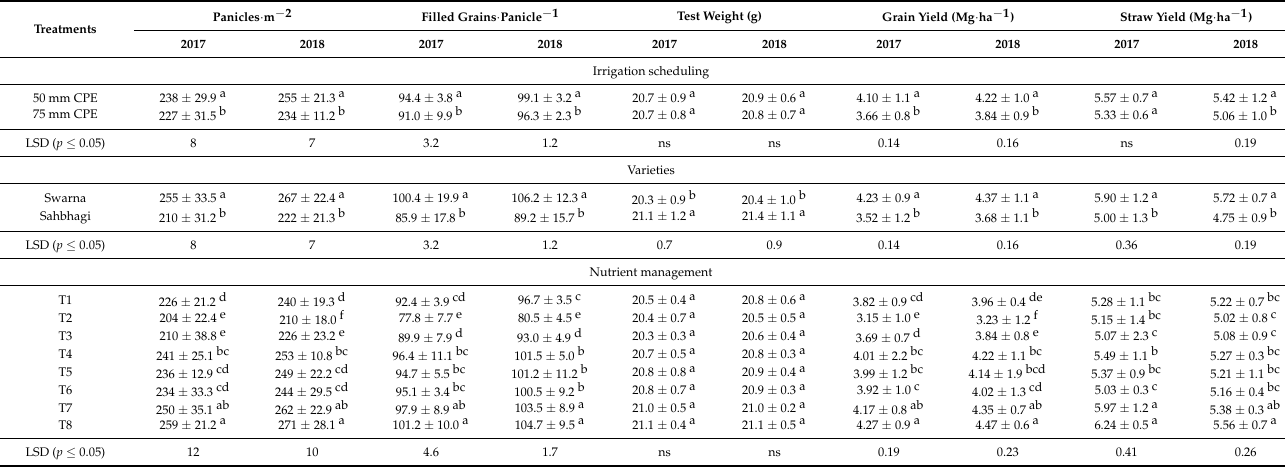
Table 5. Yield attributes and yields of rice as influenced by various irrigation scheduling, varieties and nutrient management practices along with